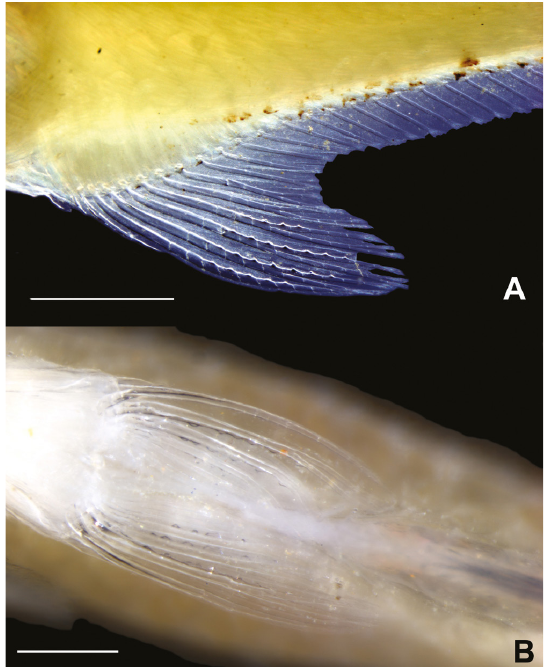
FIGURE 6 | Priocharax britzi , holotype, MZUSP 125822, 13.7 mm SL. A. Left lateral view of anal fin showing bony hooks. B. Ventral view of pelvic fin showing bony hooks. Scale bars = 0.5